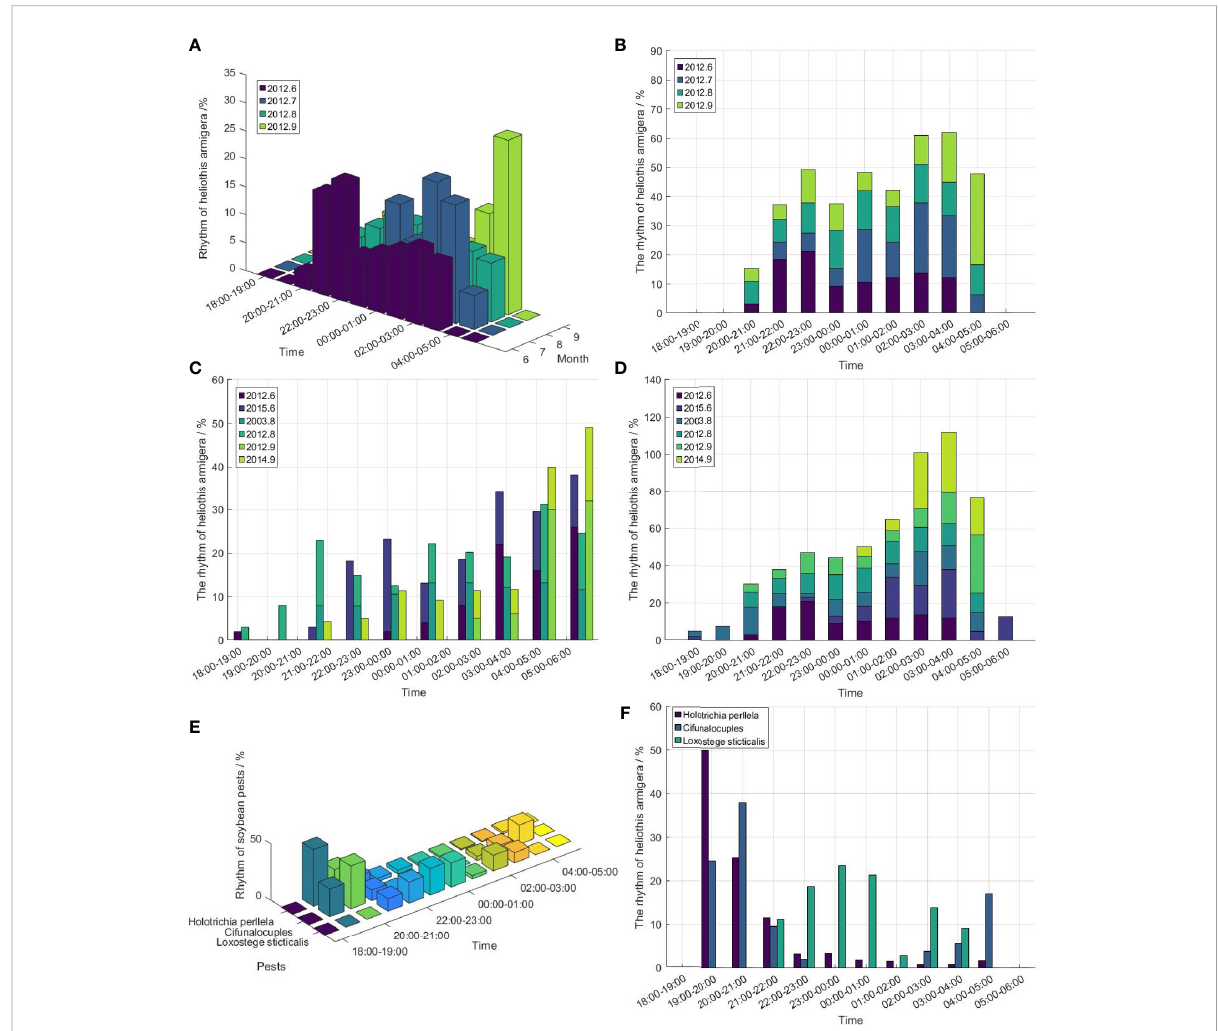
FIGURE 6 The phototactic rhythm of cotton pests. (A) The phototactic rhythm of Helicoverpa Armigera in Beijing from June to September 2012, (B) The cumulative phototactic rhythm of Helicoverpa Armigera in Beijing from June to September 2012, (C) The phototactic rhythm of Helicoverpa Armigera from June to September in different regions and years, (D) The cumulative phototactic rhythm of Helicoverpa Armigera from June to September in different regions and years. (2012.6 - Beijing, 2015.6 - Shandong, 2012.7 - Beijing, 2003.8 - Jiangsu, 2012.8 - Beijing, 2012.9 - Beijing, 2014.9 - Shandong) (E) The phototactic rhythm of Holotrichia Perllela, Cifuna Locuples Walker, Loxostege Sticticalis in cotton crops, (F) The bar chart of Rhythm for Holotrichia Perllela, Cifuna Locuples Walker, Loxostege Sticticalis in cotton